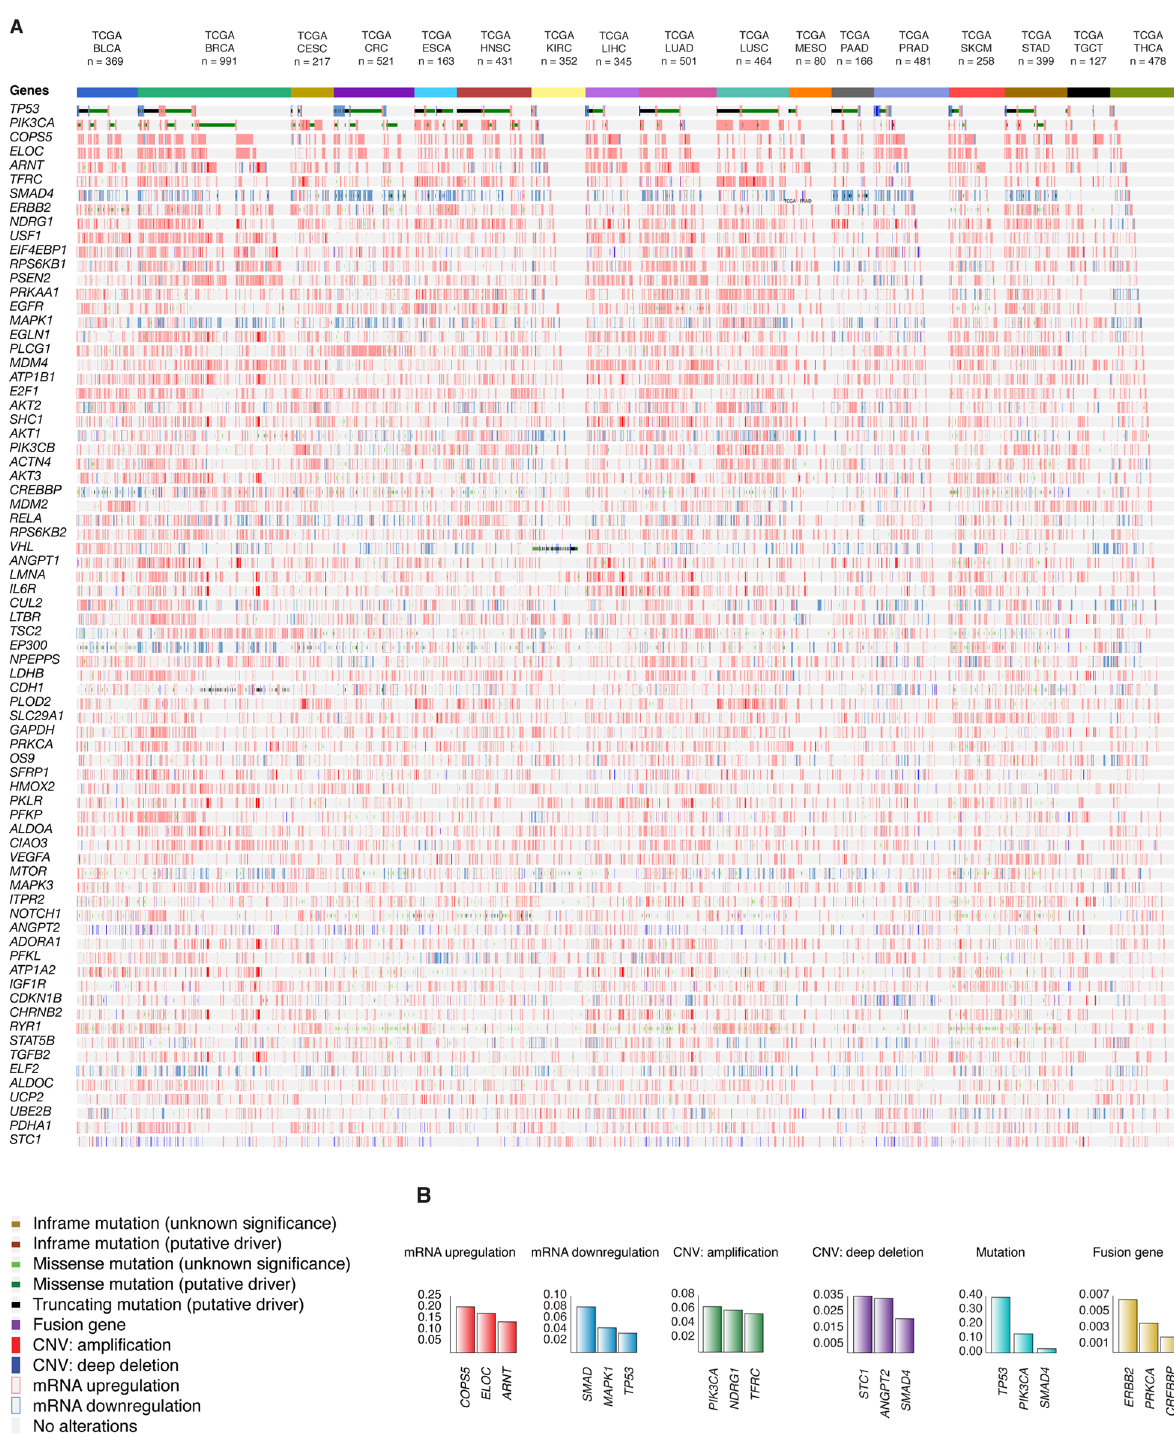
Figure 1. Panoramic landscape of genomic and transcriptomic alterations across pancarcinomas from PCA- TCGA. ( A ) OncoPrint (mRNA high, mRNA low, CNV amplification, CNV deep deletion, putative driver mutation and fusion genes) of the most altered hypoxia-related genes. ( B ) Ranking of the most altered hypoxia- related genes per alteration type. TCGA: The Cancer Genome Atlas; BLCA: bladder urothelial carcinoma; BRCA: breast invasive carcinoma; CESC: cervical squamous cell carcinoma and endocervical carcinoma; CRC: colorectal adenocarcinoma; ESCA: esophageal carcinoma; HNSC: head and neck squamous cell carcinoma; KIRC: kidney renal clear cell carcinoma; LIHC: liver hepatocellular carcinoma; LUAD: lung adenocarcinoma; LUSC: lung squamous cell carcinoma; MESO: mesothelioma; PAAD: pancreatic adenocarcinoma; PRAD: prostate adenocarcinoma; SKCM: skin cutaneous melanoma; STAD: stomach adenocarcinoma; TGCT: testicular germ cell tumors; THCA: thyroid carcinoma; CNV: copy number